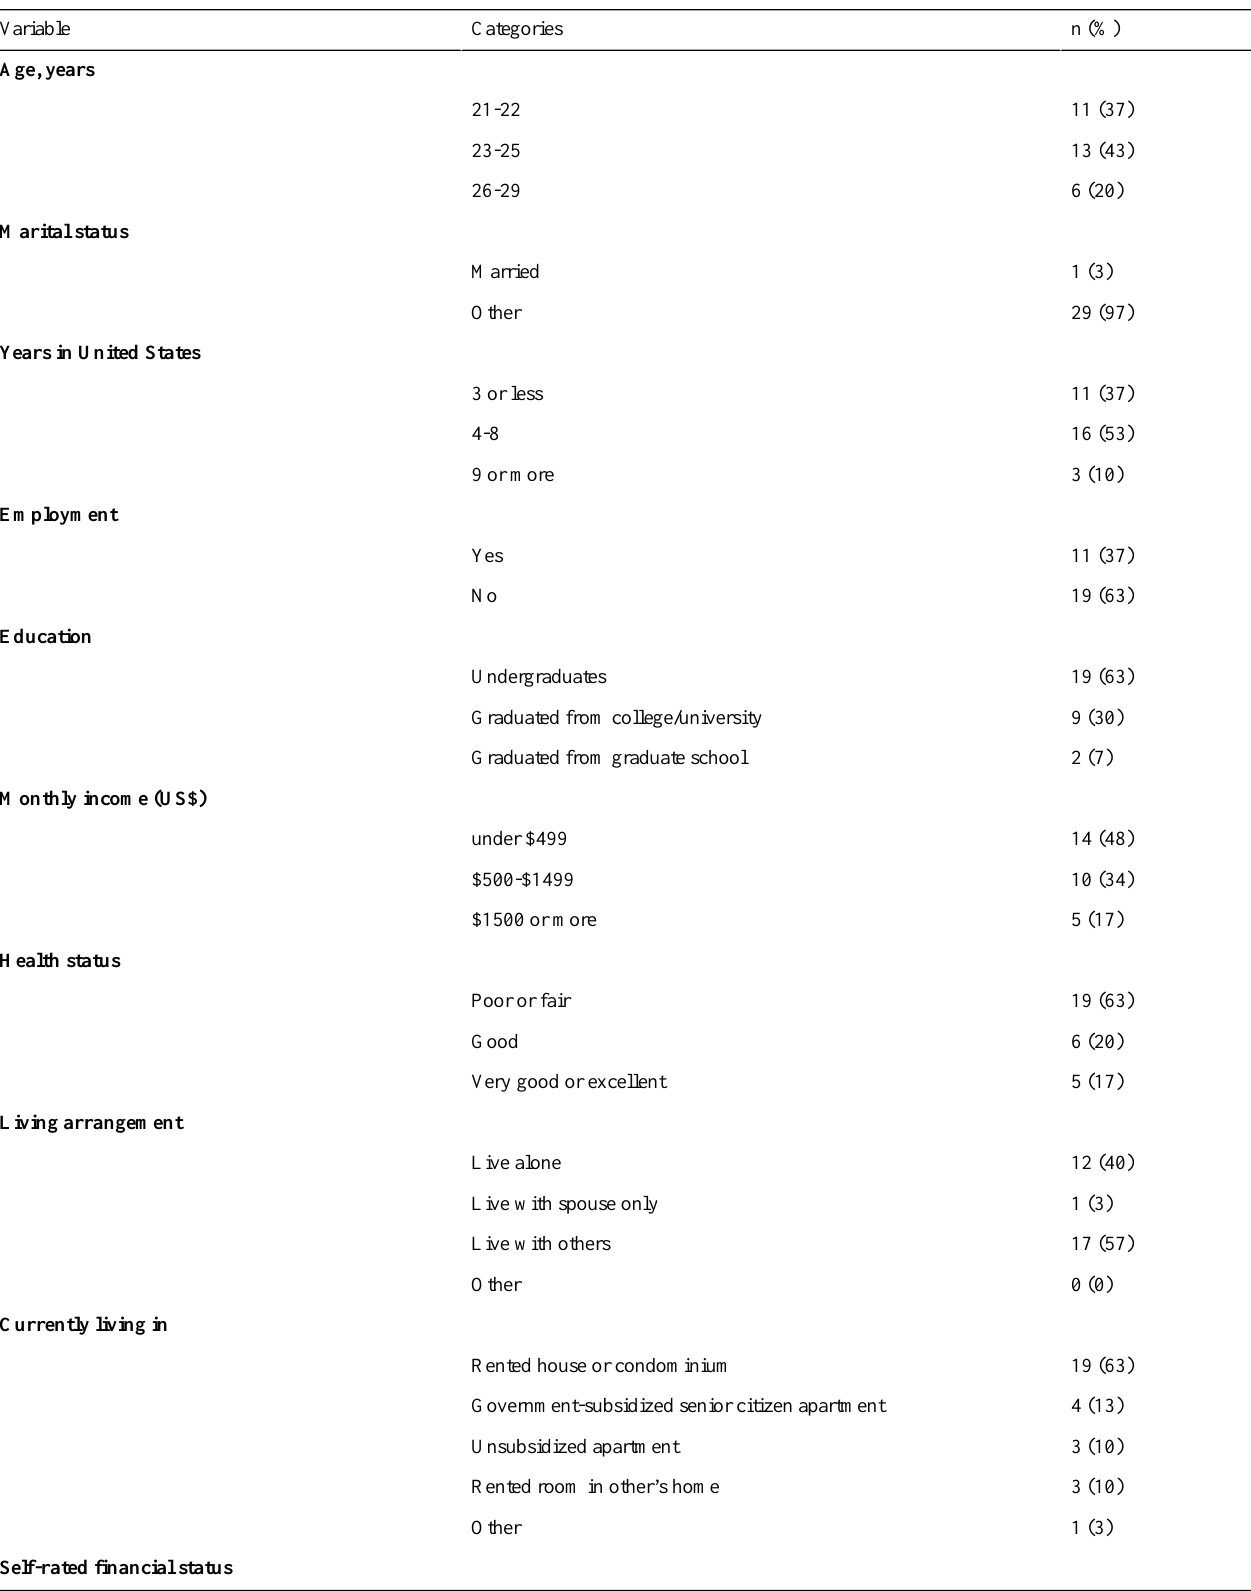
Table 1. Baseline sociodemographic characteristics of the sample